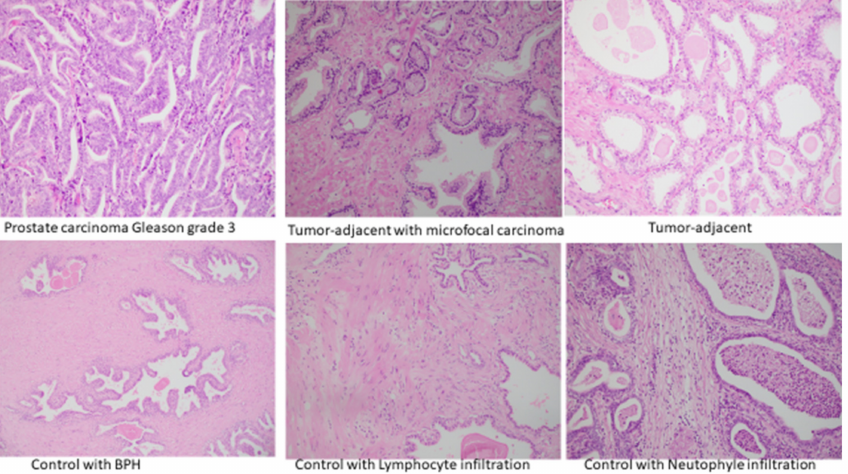
Figure 8. Histological findings of PC, tumor-adjacent tissue with microfocal carcinoma, tumor- adjacent, and control healthy tissue